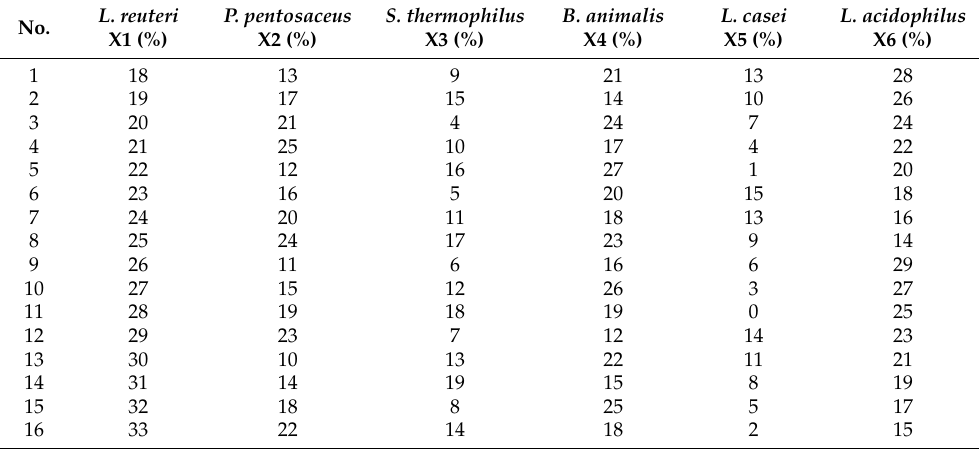
Table 1. Uniform design table for the experiment.